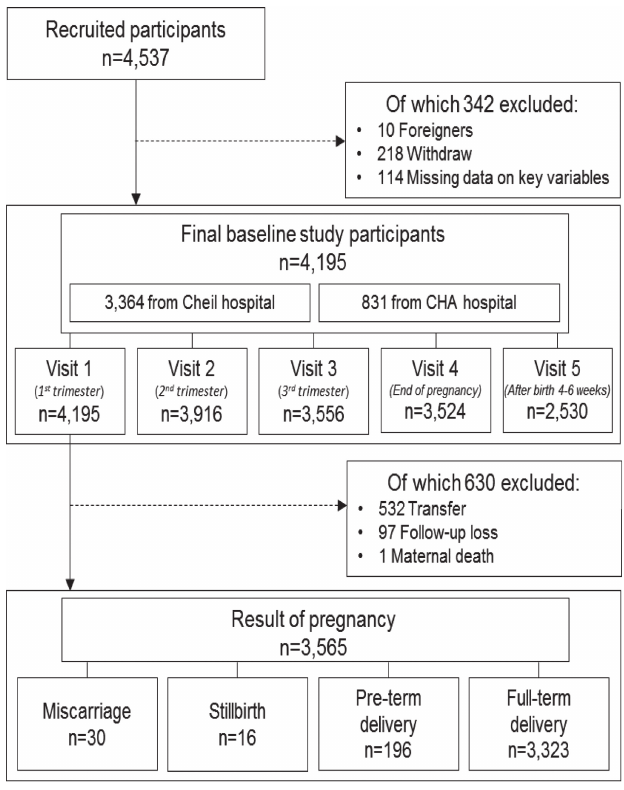
Figure 1. The fl owchart of KPOS